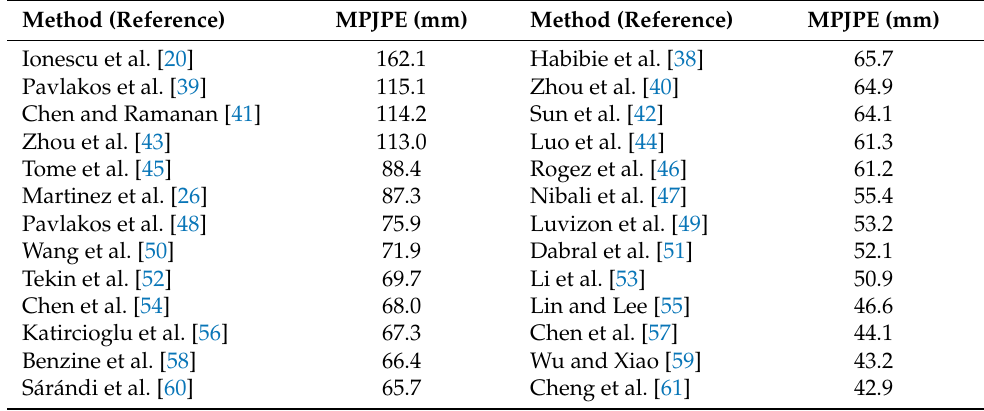
Table 1. Mean per-joint position error (MPJPE) for state-of-the-art approaches on H36M.